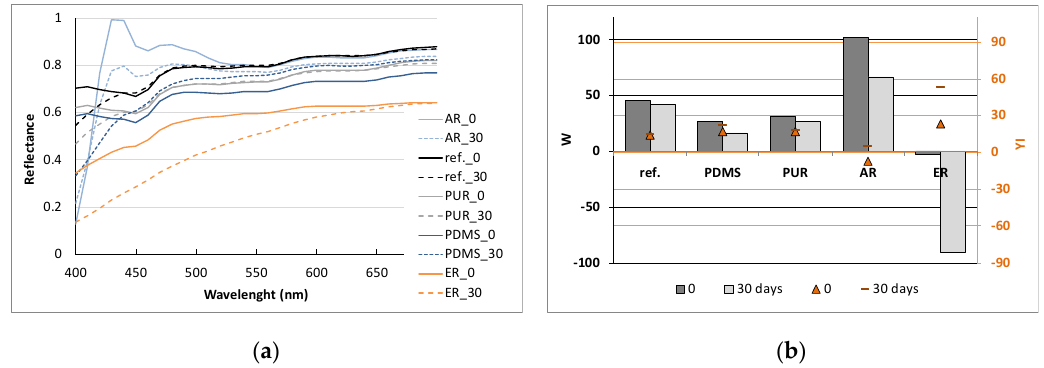
Figure 5. Samples before 0 and after 30 days of UV light exposure: reflectance curves ( a ) and W and YI values ( b ).